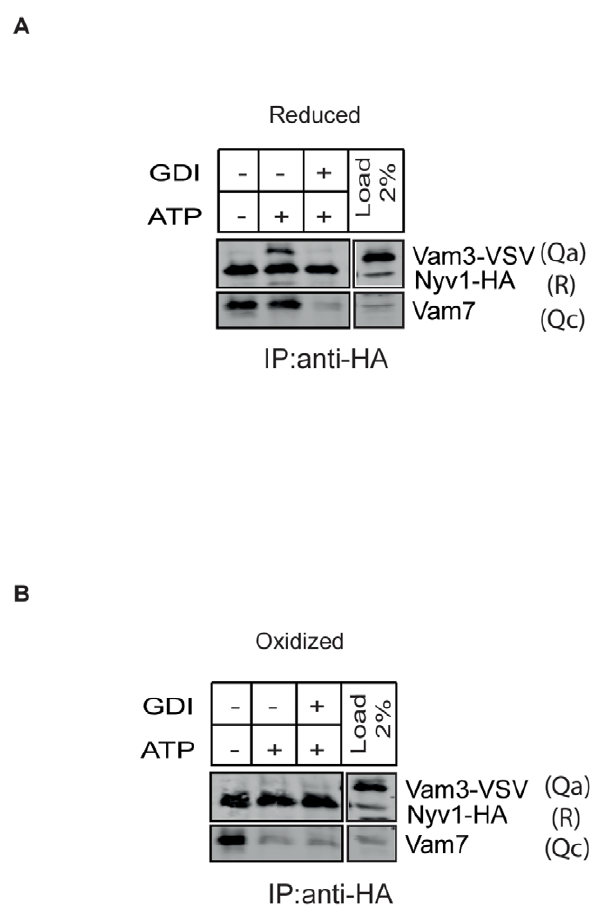
Figure 5. Effect of oxidation on trans -SNARE complex formation. Trans -SNARE assay for oxidized and reduced vacuoles. Reduced (Figure 5A) or oxidized (Figure 5B) Nyv1-HA and Vam3-VSV tagged vacuoles were harvested from gradients containing DTT or H 2 O 2 . Oxidized or reduced Nyv1-HA and Vam3-VSV vacuoles were mixed in a 1:1 ratio and incubated in the presence or absence of ATP and GDI. After 5 min of incubation at 27 u C and 30 min incubation at 7 u C, vacuoles were solubilized with Triton X-100 in PS buffer and immunoadsorbed to anti- HA protein G beads. Bound proteins were separated by SDS-PAGE, blotted, and probed with the indicated antibodies. Oxidation does not impair priming, but suppresses trans-SNARE formation.